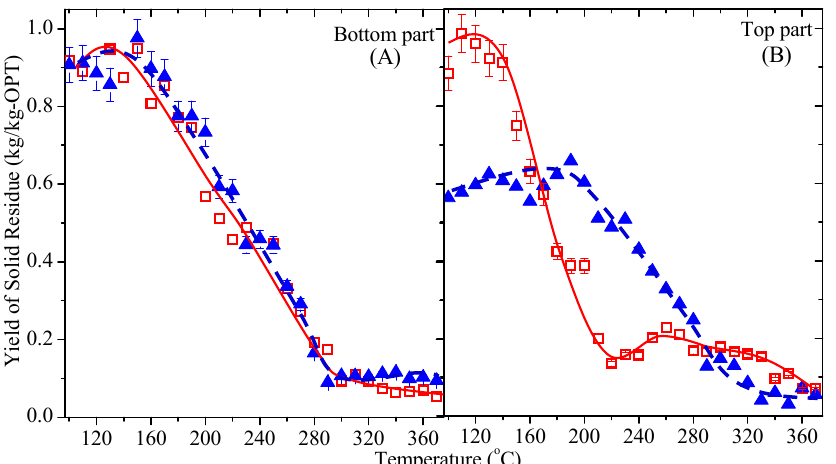
Figure 8. The e ff ect of the reaction temperature on the yield of solid residue after OPT21 ( (cid:3) ) and OPT35 Figure 8. The effect of the reaction temperature on the yield of solid residue after OPT21 ( □ ) and ( (cid:78) ) were subjected to sub-CW for 5 min. ( A ) Bottom and ( B ) top OPT35 ( ▲ ) were subjected to sub-CW for 5 min. ( A ) Bottom and ( B ) top sections.